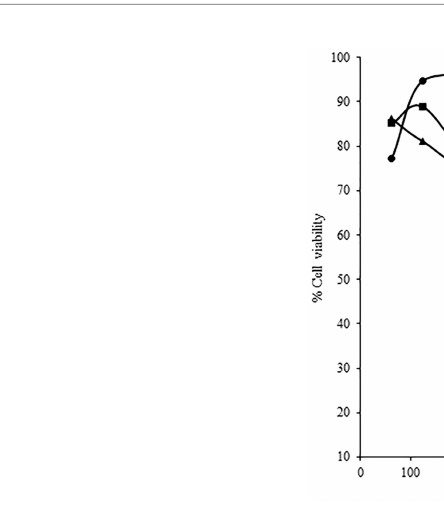
FIGURE 3 | Cell cytotoxicity of sea cucumber hydrolysates prepared with papain (SCP), alcalase (SCA) and fl avourzyme (SCF) on human keratinocyte cells lines (HaCaT